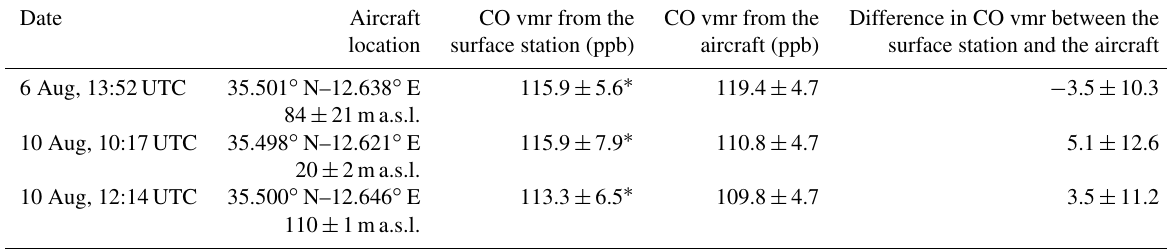
Table 1. Comparison of the CO dry volume mixing ratio (vmr) measurements between the WMO/GAW surface station (Picarro instrument) in Lampedusa island (35.52 ◦ N–12.63 ◦ E; 45ma.s.l.) and the aircraft (SPIRIT